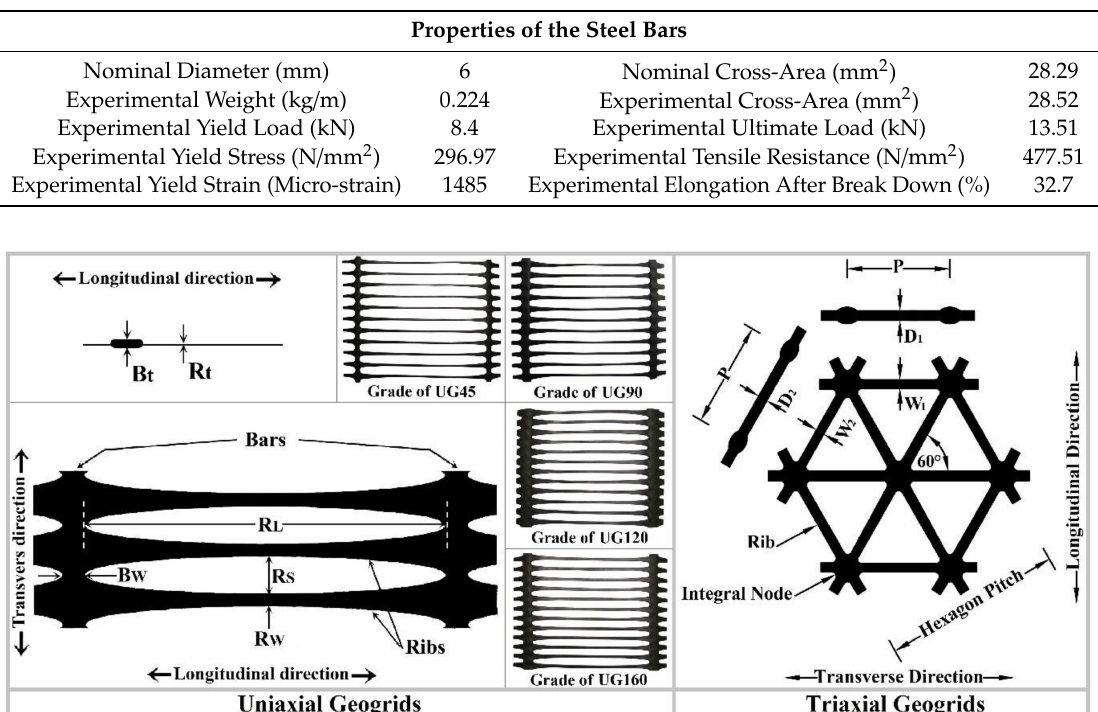
Table 2. The reinforcement steel bars’ properties as per experimental tests.